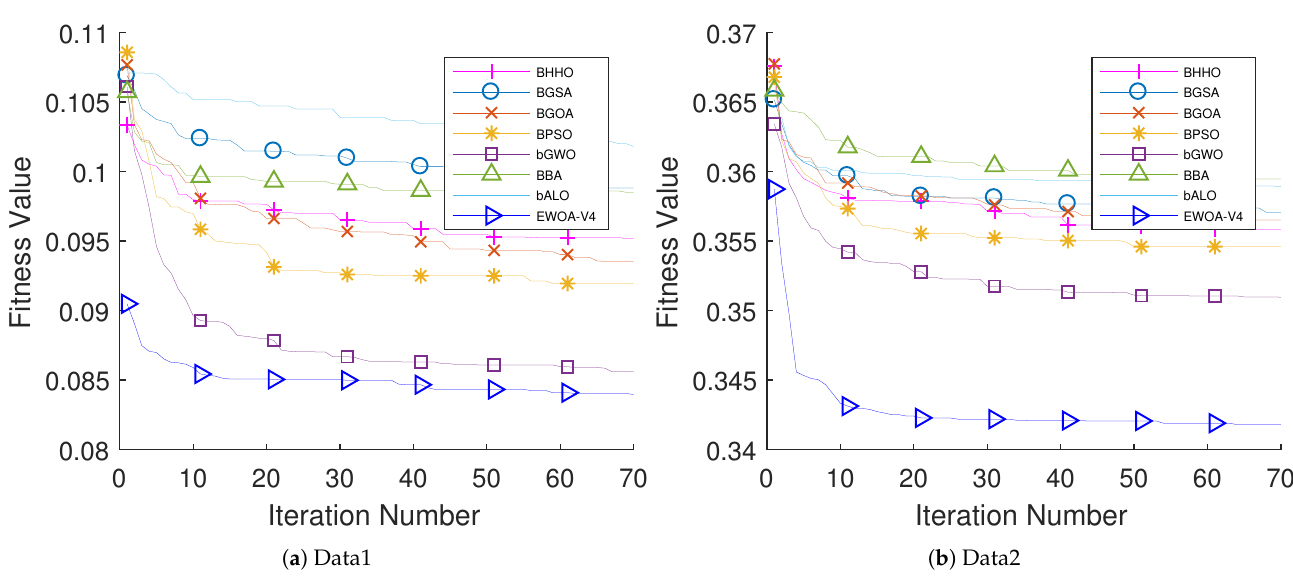
Figure 16. Convergence curves for all compared algorithms. Table 17. Comparison of the proposed approaches with other well-regarded algorithms in terms of AUC, selected features, and fitness values.